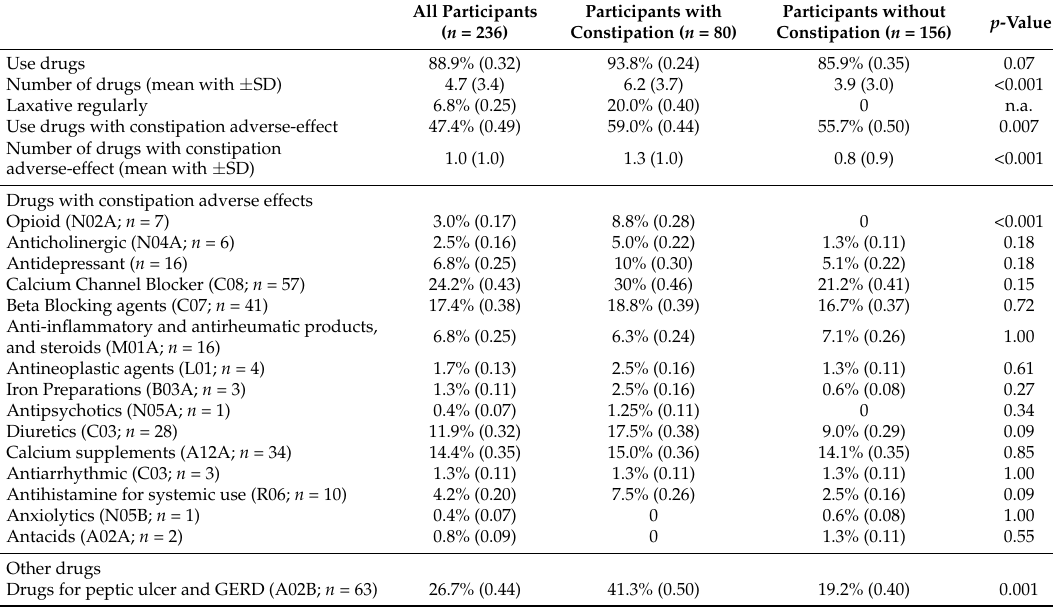
Table 2. Mean (SD) or proportion ( ± SD) of drug use, number of drugs, regular use of laxatives, use of drugs with constipation adverse effect, number of drugs with constipation adverse effect for all participants and these values alongside p -values for comparisons between participants with and without